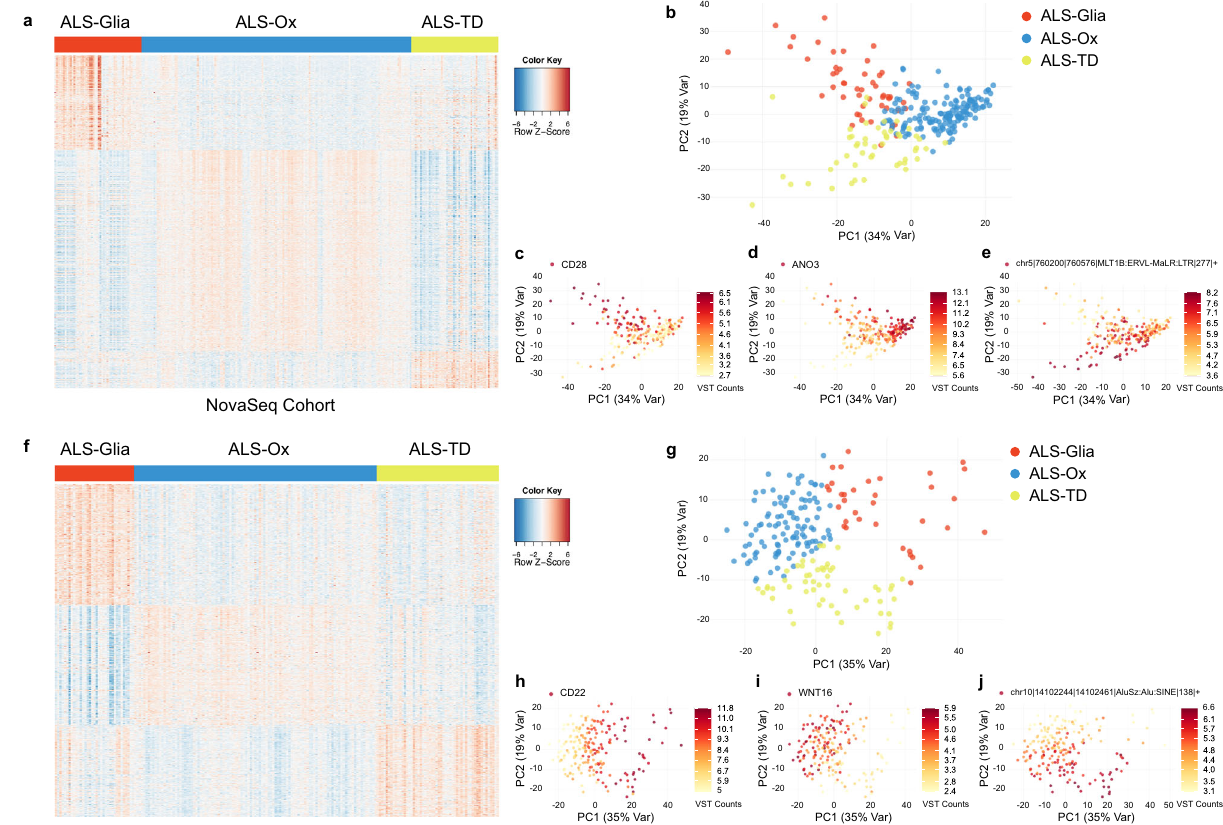
Fig. 1 | Unsupervised clustering analysis with ALS postmortem cortex transcriptomes. a Heatmap of 741 genes and transposable elements selected by SAKE 113 shows transcript overexpression in a subtype-speci fi c fashion for the NovaSeq cohort ( n =255 biologically independent samples). Transcript counts are z-score normalized. b Principal component analysis shows three distinct clusters whenconsideringthe fi rsttwoprincipalcomponents. c Sampleexpressionof CD28 transcripts was plotted in the same PCA space, with elevated counts seen for the ALS-Glia subtype. A darker color corresponds to higher feature expression. d Expressionofthe ANO3 geneshowsspeci fi cityfortheoxidativestressandaltered